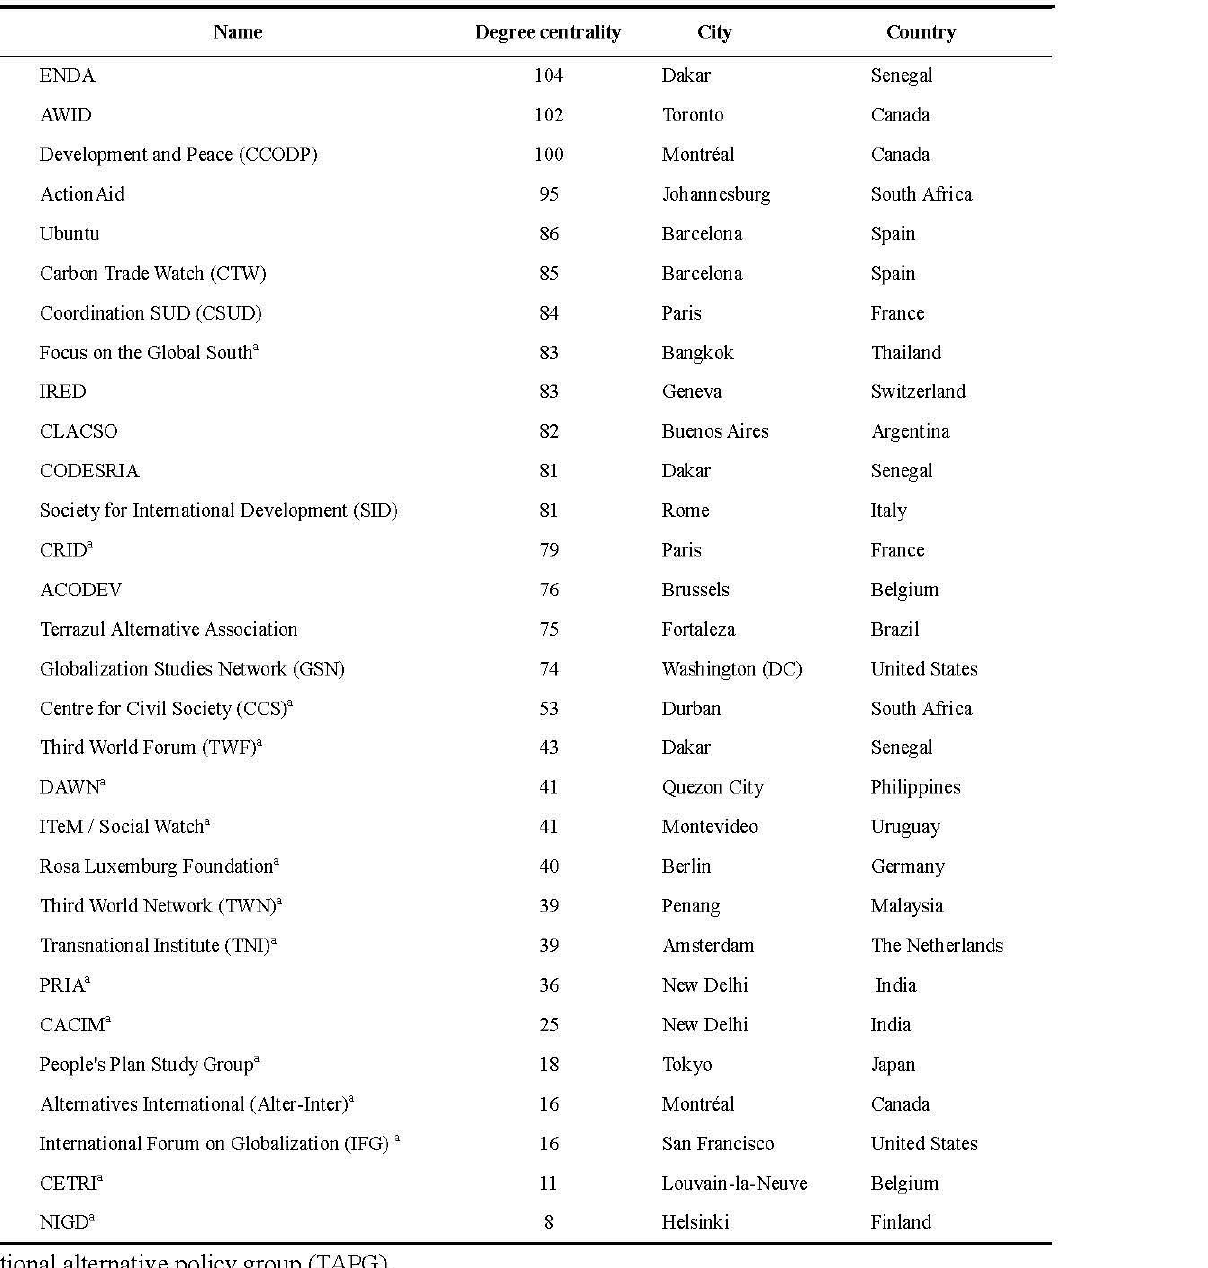
Table 3. 30 most central organizations in the network of 3977